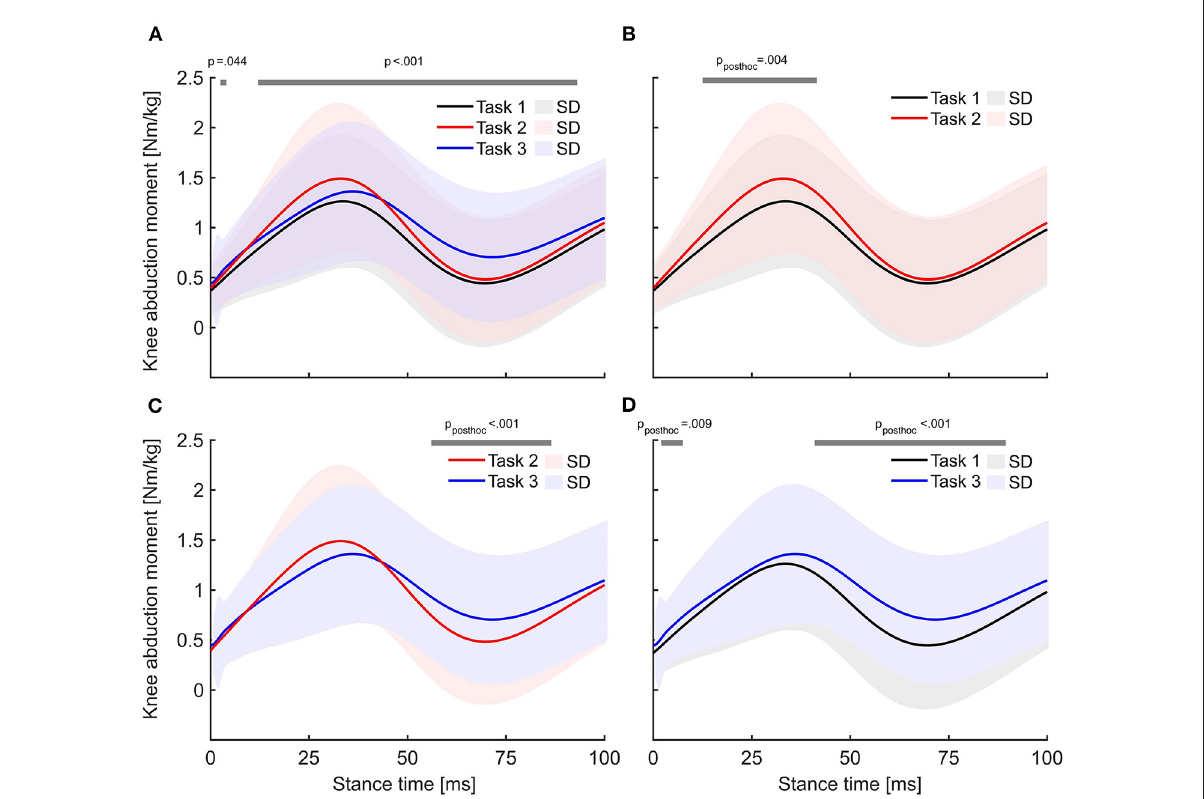
FIGURE3 Average external knee abduction moment curves within the first 100ms of stance. (A) Statistical parametric mapping results using repeated-measures ANOVA. The gray lines above the graph indicate significant differences over the respective time interval. (B–D) Pairwise comparison of the knee abduction moment curves for each possible task combination, gray lines highlighting significant differences over time using Bonferroni-corrected alpha